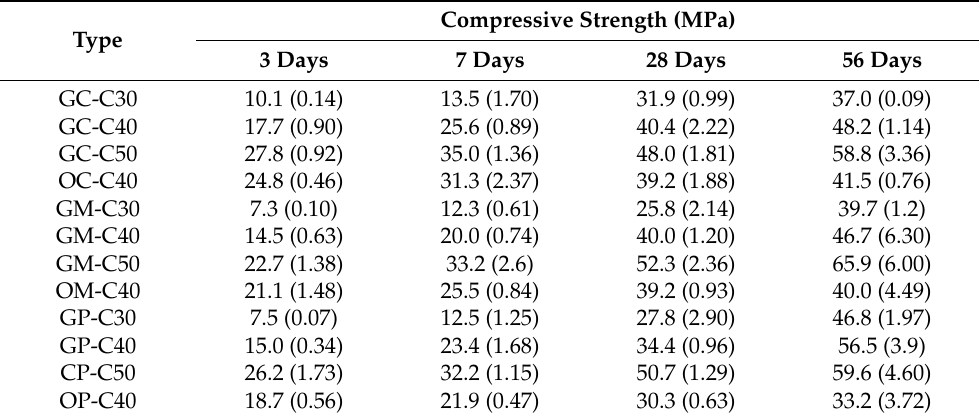
Table 3. Compressive strength of concrete, mortar and paste specimen with curing time.